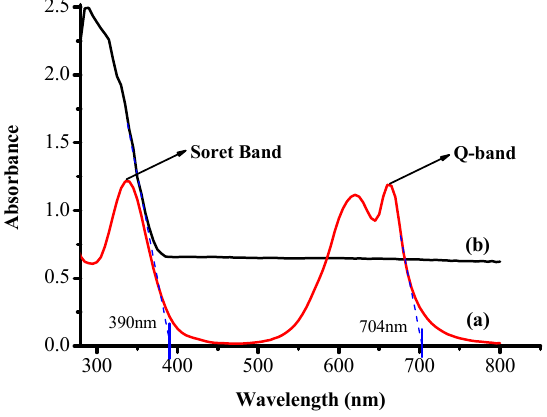
Figure 5. UV ‐ Visible absorption spectra of ( a ) RB ‐ 25 in water and ( b ) TiO 2 ‐ coated cotton fabric. The energy gaps were measured from the absorption wavelength using a simple energy equation as given in the Table 2.